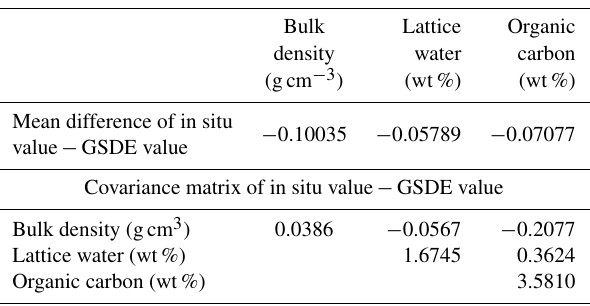
Table 2. Top: summary of mean difference between in situ sam- ples and GSDE values (Fig. 3) for bulk density, lattice water, and organic carbon. Bottom: summary of covariance matrix of differ- ence between in situ values and GSDE values. The mean difference and covariance data were used in an error propagation analysis il- lustrated in Fig.